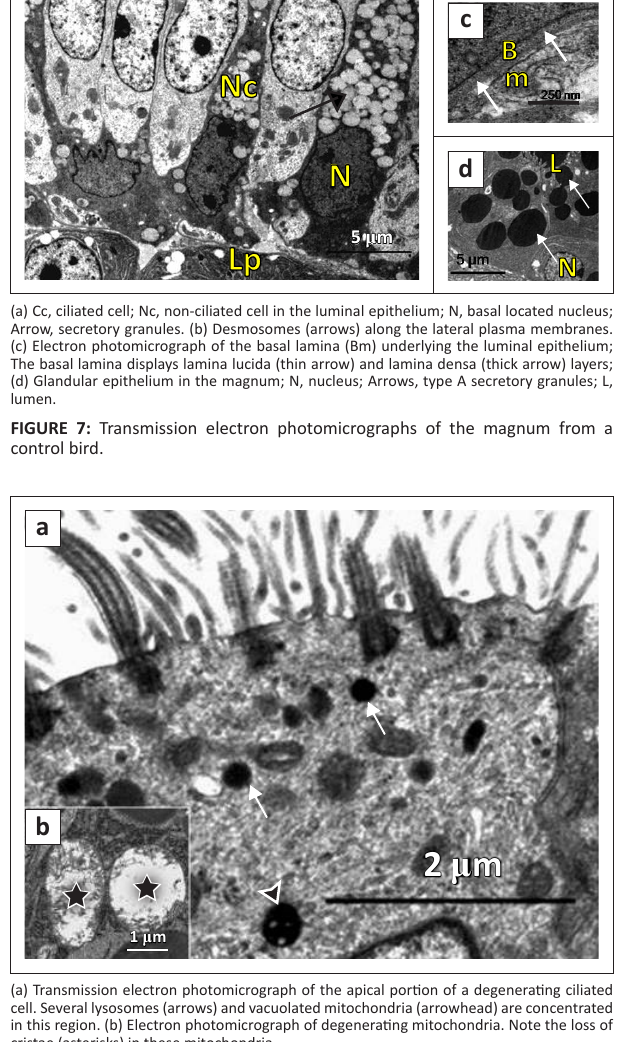
FIGURE 8: Electron micrographs of magnum mucosa from a bird treated with 400 mg/kg bodyweight